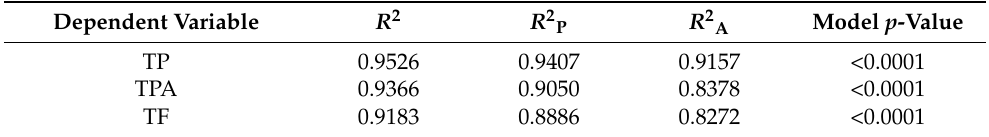
Table 3. Coefficients of determination ( R 2 ) and p -value of ANOVA analysis for the models of extraction of total phenols (TP), total phenolic acids (TPA), and total flavonoids (TF). Dependent Variable R 2 R 2 P R 2 A Model p -Value TP 0.9526 0.9407 0.9157 <0.0001 TPA 0.9366 0.9050 0.8378 <0.0001 TF 0.9183 0.8886 0.8272 <0.0001 R 2 A = adjusted R 2 ; R 2 P = predicted R 2 .